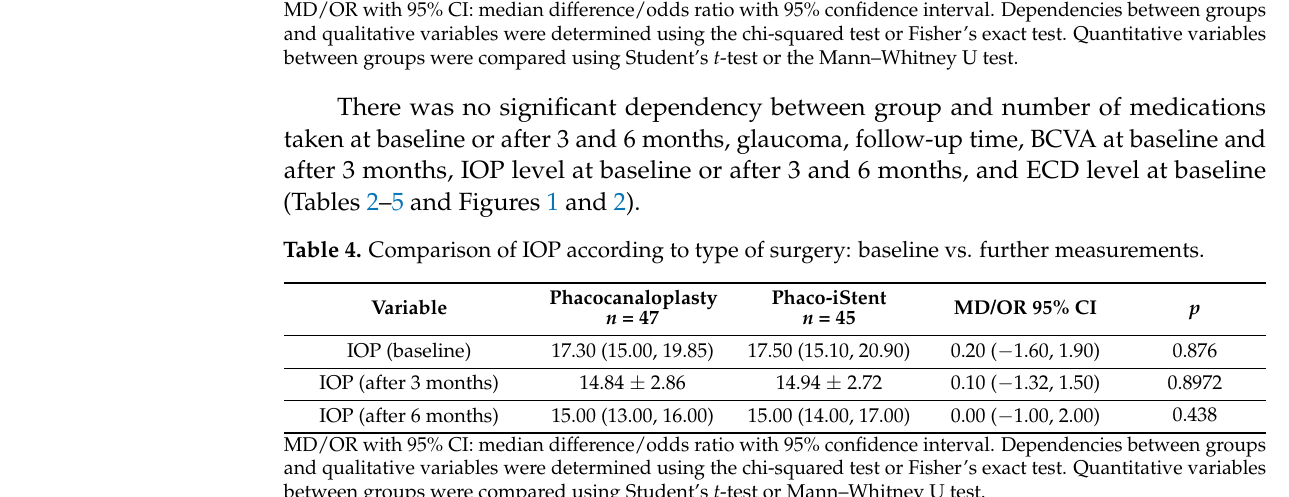
Table 5. Comparison of antiglaucoma medications according to type of surgery–baseline